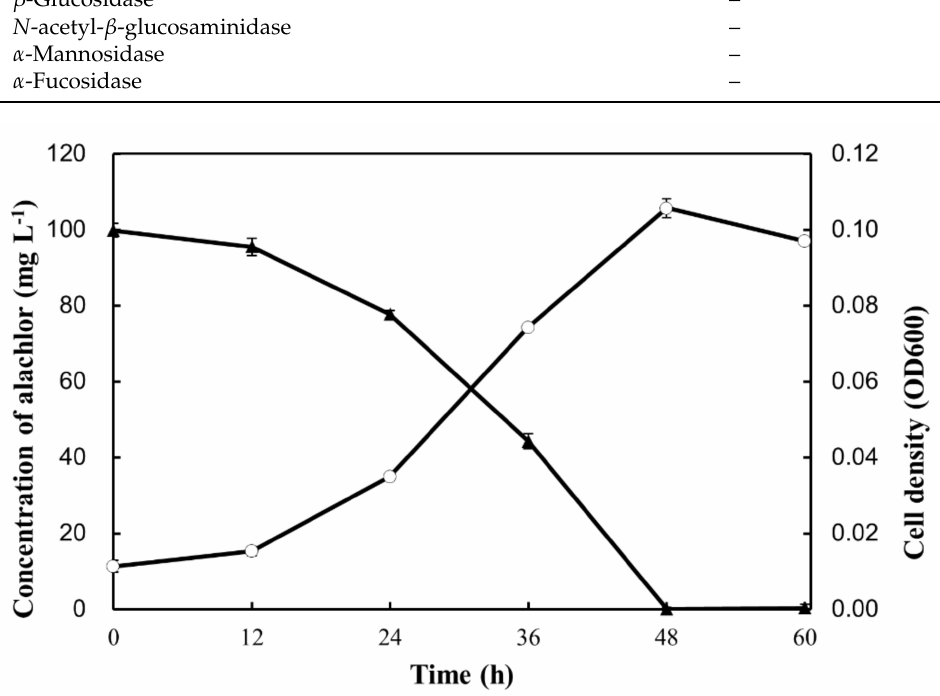
Figure 3. Utilization and degradation of alachlor by Acinetobacter sp. GC-A6 in alachlor mineral medium. ( ) OD 600 of strain GC-A6 cultures; ( (cid:78) ) residual concentration of alachlor in strain GC-A6 (cid:35) cultures. Error bars indicate the standard deviation of values measured in triplicate at each point. HPLC spectrums obtained from the cultures at 0 h and 48 h are shown in Figure 4. HPLC spectra obtained from the culture at 0 h showed two large peaks. The